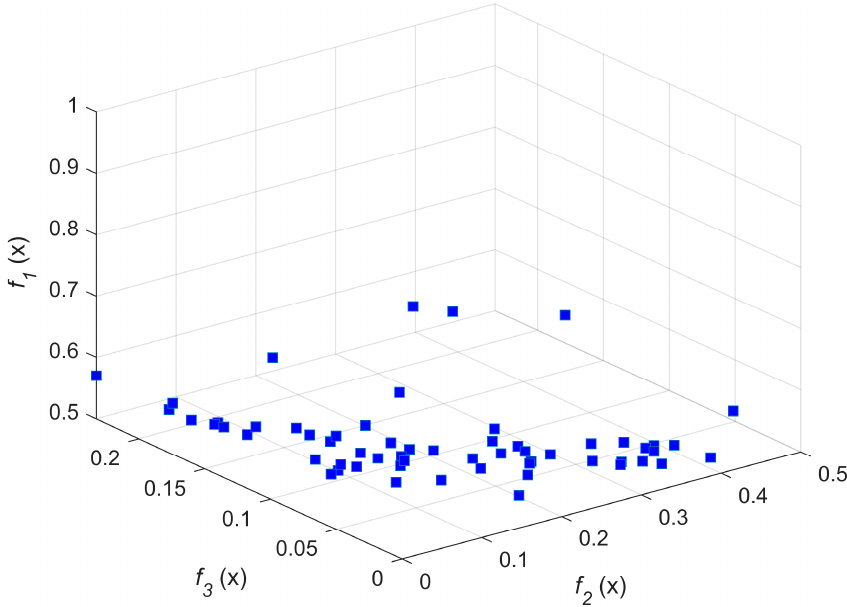
Figure 7. Pareto front of the feasible optimal solutions.